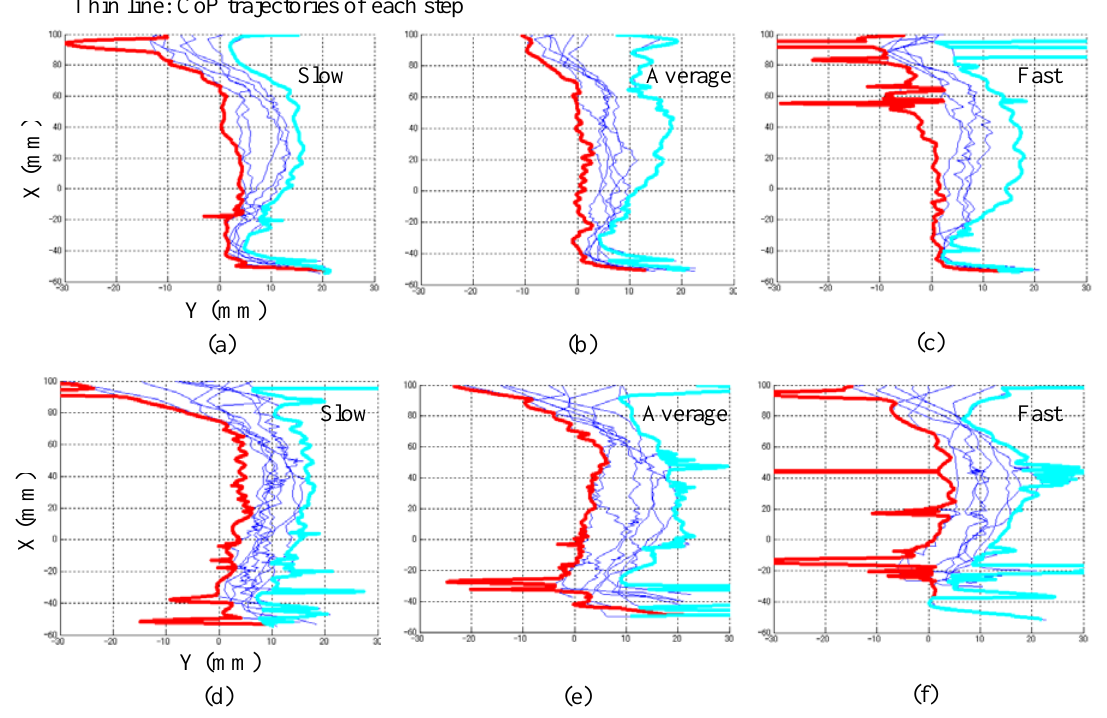
Figure 5. Representative plots of CoP envelope curves (thick lines) and CoP trajectories for each step in the successive walking trials. CoP trajectories of the six trials were given in the six sub-plots in which the horizontal axis and vertical axis were defined as medial-lateral direction and anterior-posterior direction respectively. Moreover, the left and right envelope curves were plotted using a widening solid line for each trial. (a) , (b) and (c) are the results of the first set of walking trials with a lead line under slow, preferred and fast speed respectively. Thick lines: CoP envelope curves Thin line: CoP trajectories of each